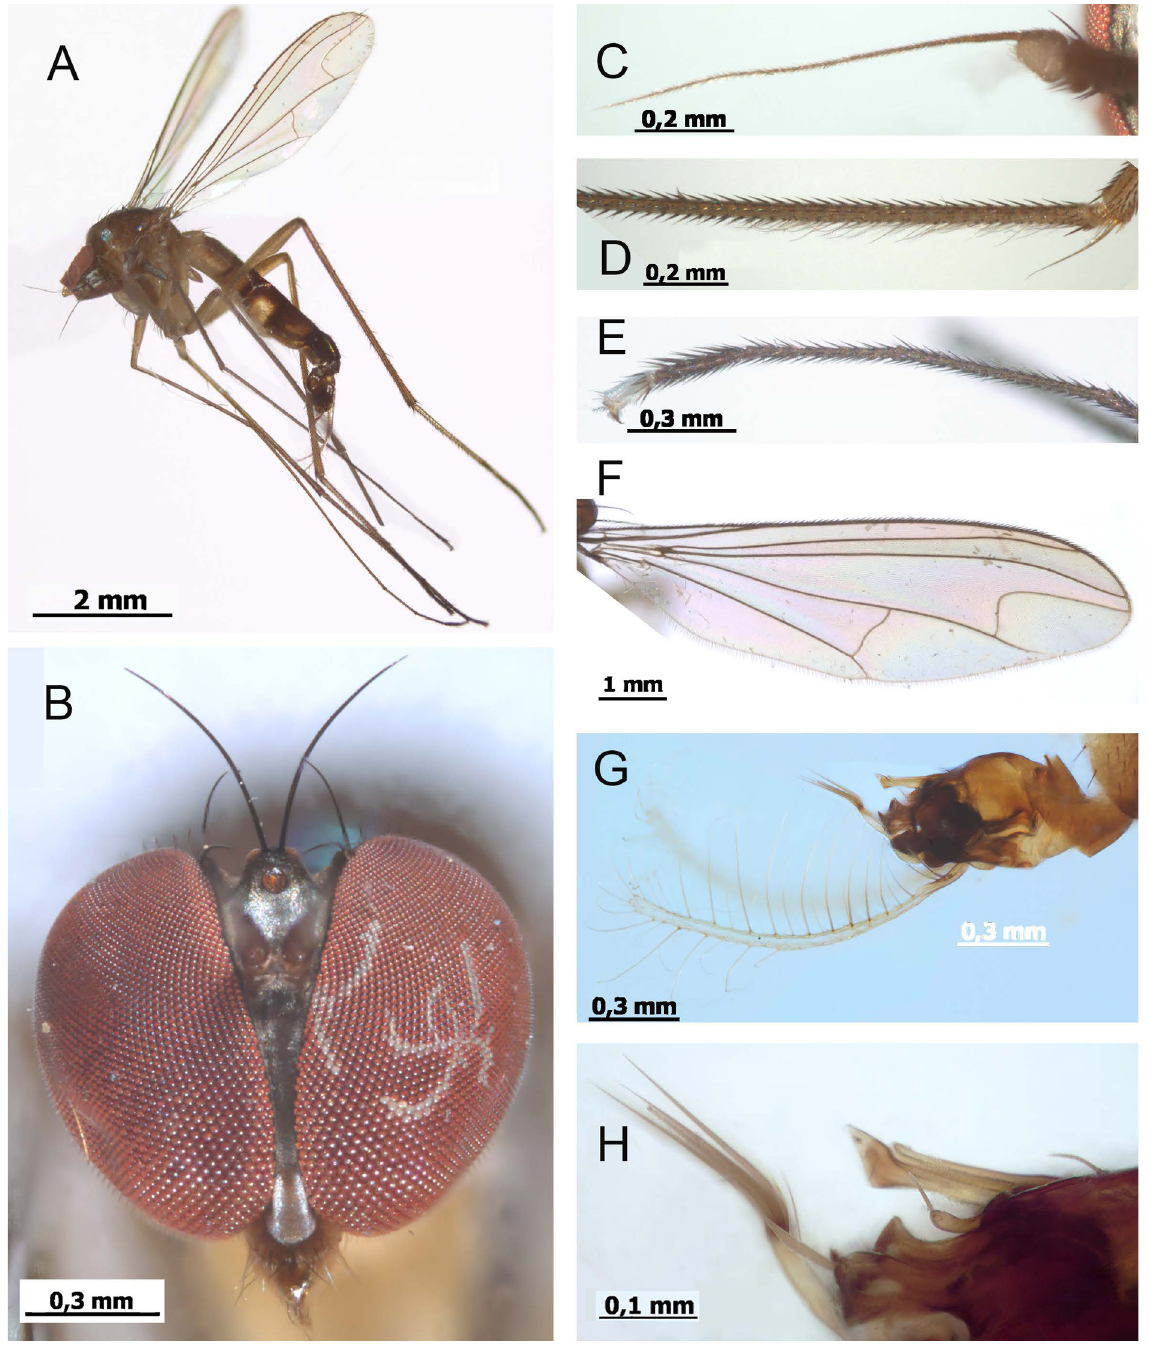
Fig. 10. Amblypsilopus freidbergi sp. nov. A–F . Holotype, ♂ (SMNHTAU). G–H . Paratype, ♂ (SMNHTAU). A . Habitus. B . Head. C . Antenna. D . Fore basitarsus. E . Fore tarsomeres 2–5. F . Wing. G . Hypopygium, left lateral view, reflected light. H . Distoventral appendages of hypopygium, transmitted